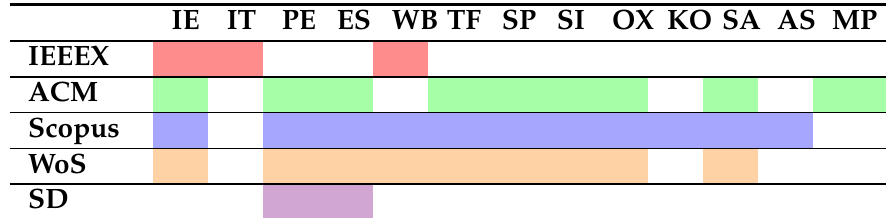
Table 6. Databases coverage with respect to the content of the publishers: IE = IEEE, IT = IET, PE = Pegamon-Elsevier, ES = Elsevier Science, WB = Wiley Blackwell, TF = Taylor & Francis, SP = Springer, SI = SIAM Publications, OX = Oxford University Press, KO = Korean Inst. Electrical Eng., SA = Sage Publications, AS = ASME, MP = Microtome Publications